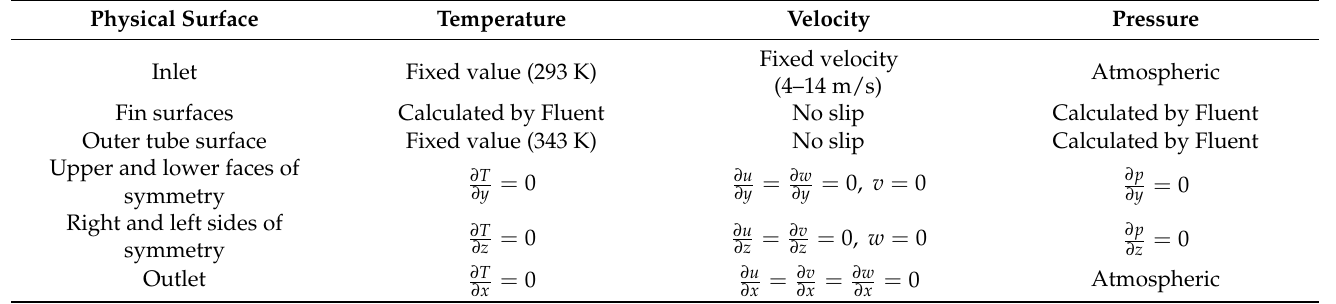
Table 2. Boundary conditions.